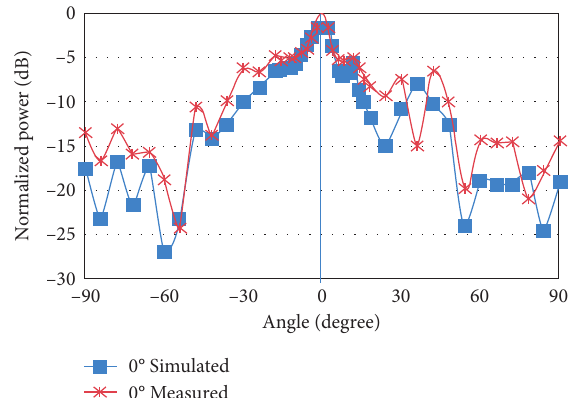
Figure 6: Measured and simulated radiation patterns for 0 ° primary beam at 10GHz.